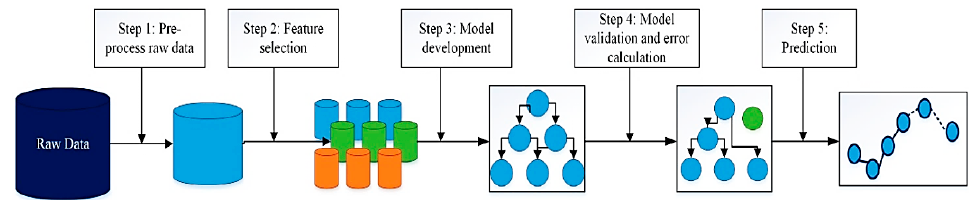
Figure 4. Advanced architecture adopted for data detection and processing.